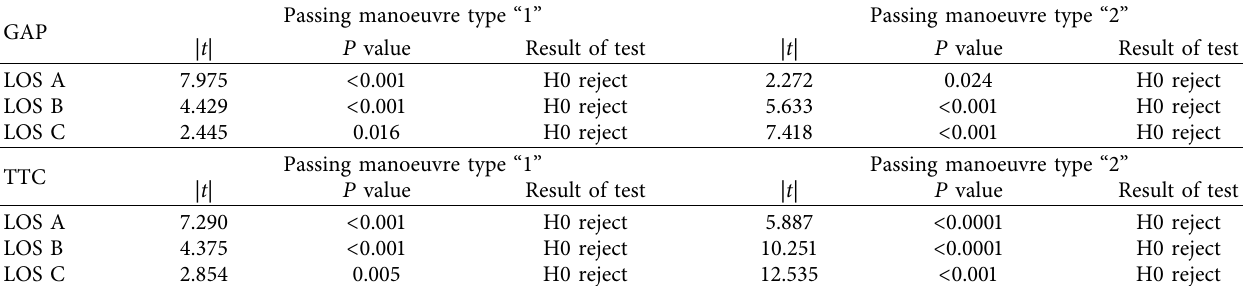
Table 12: Result of statistical test for the GAP and TTC values recorded in the two microscopic traffic simulations performed. GAP